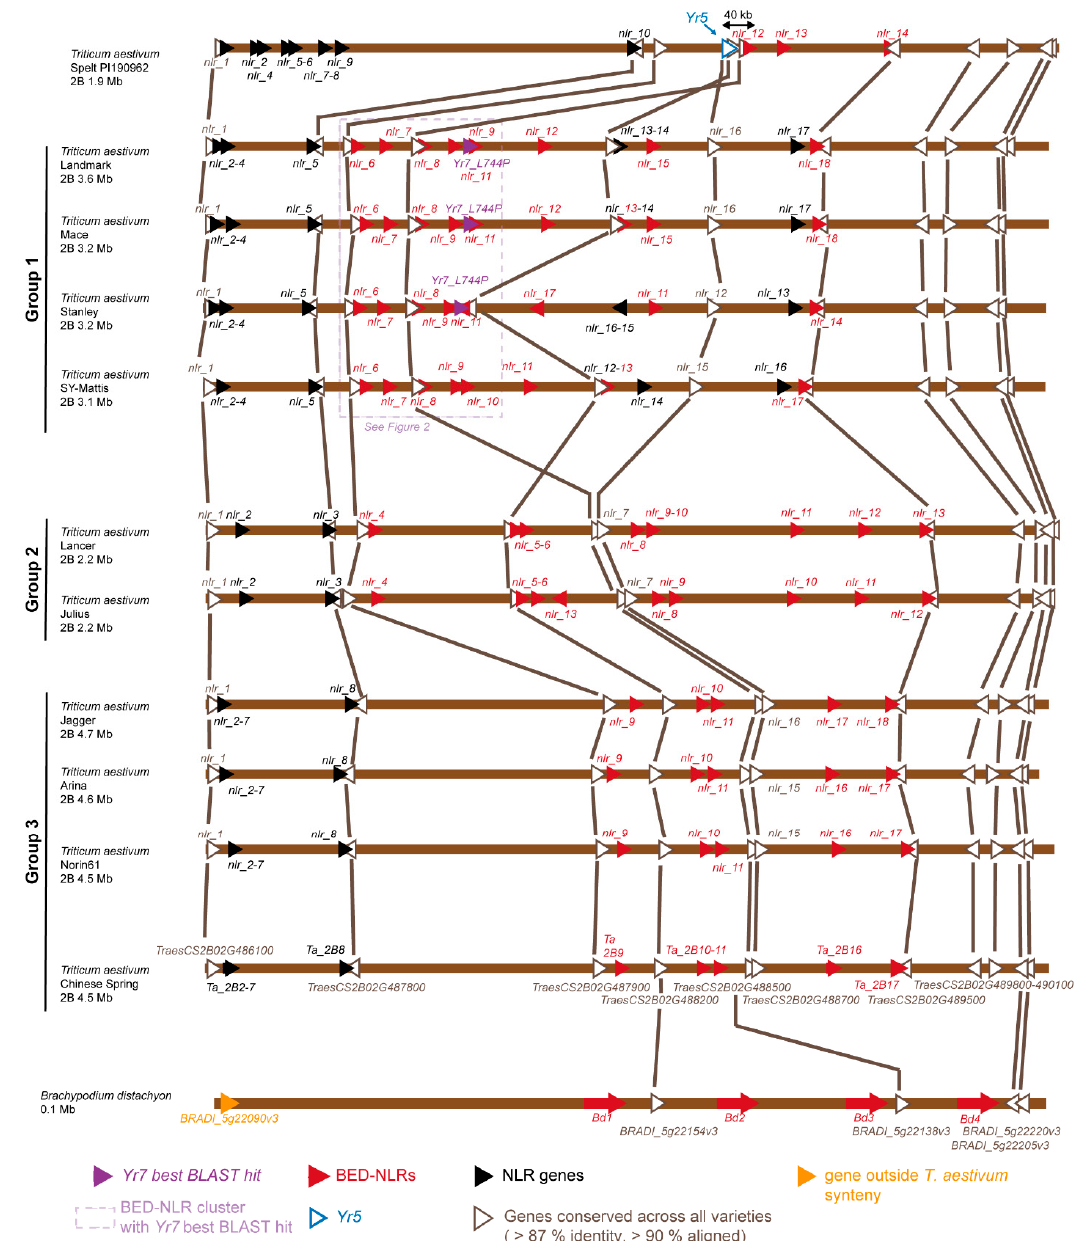
Figure 1. Schematic representing the Yr region in ten wheat varieties, a spelt variety and B. distachyon . The syntenic region was defined based on the eleven gene models with hits across all varieties (gene models shown as white triangles). Dark brown represents the region of chromosome 2B in synteny with the Yr region on RefSeqv1.0. Black triangles show potential canonical NLR loci annotated with NLR-Annotator and red triangles potential BED-NLR loci (Table S3). Purple triangles depict Yr7 best BLAST hit in Group 1 varieties ( Yr7_L477P ) and the white triangle with a blue outline shows Yr5a in spelt. The BED-NLR-rich region in the vicinity of the Yr7 is highlighted with a dashed light purple line (see Figure 2 for details). The orientation of the triangles reflects the orientation of the gene model. The orange triangle in B. distachyon represents a gene that was outside of the synteny with wheat. NLRs sharing 100% identity across 95% of their sequences are reported in Table S4.